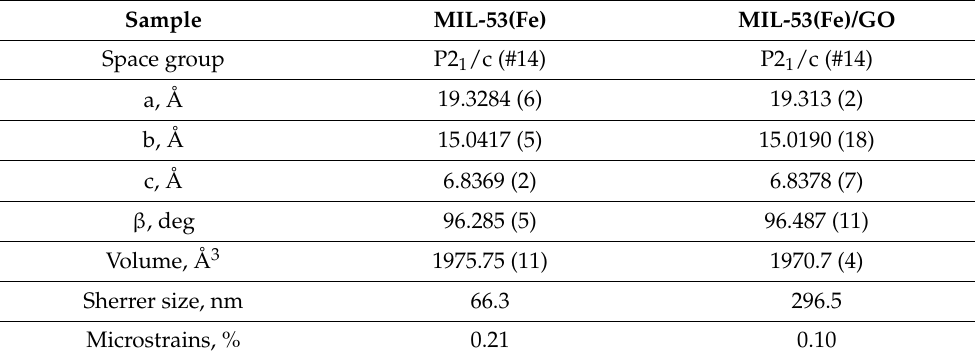
Table 2. Structural parameters of studied samples based on synchrotron powder diffraction